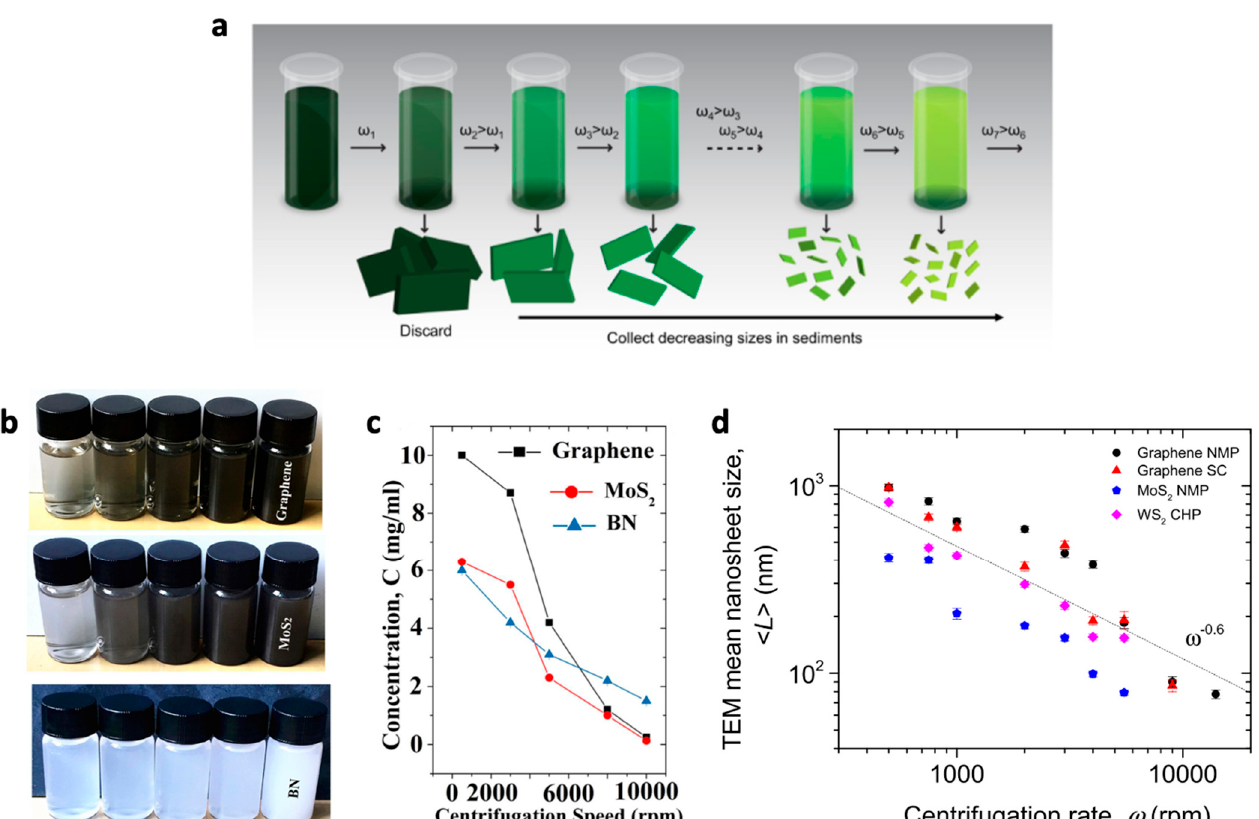
Figure 1. ( a ) Schematic of the size selection by liquid cascade centrifugation. Reprinted with permission from Ref. [52]. Copyright 2016 MyJoVE. ( b ) Photographs of aqueous dispersions of graphene, MoS 2 , and BN with different concentrations after centrifugation at 500–10,000 rpm for 30 min; ( c ) Lambert–Beer plots for graphene, MoS 2 , and BN; dependence of 2D material concentration on centrifugation speed for the supernatant. Reprinted with permission from Ref. [51]. Copyright 2018, IOP Publishing. ( d ) Mean nanosheet length ( L ), versus centrifugation rate ( ω ). Reprinted with permission from Ref. [50] . Copyright 2013 IOP Publishing.